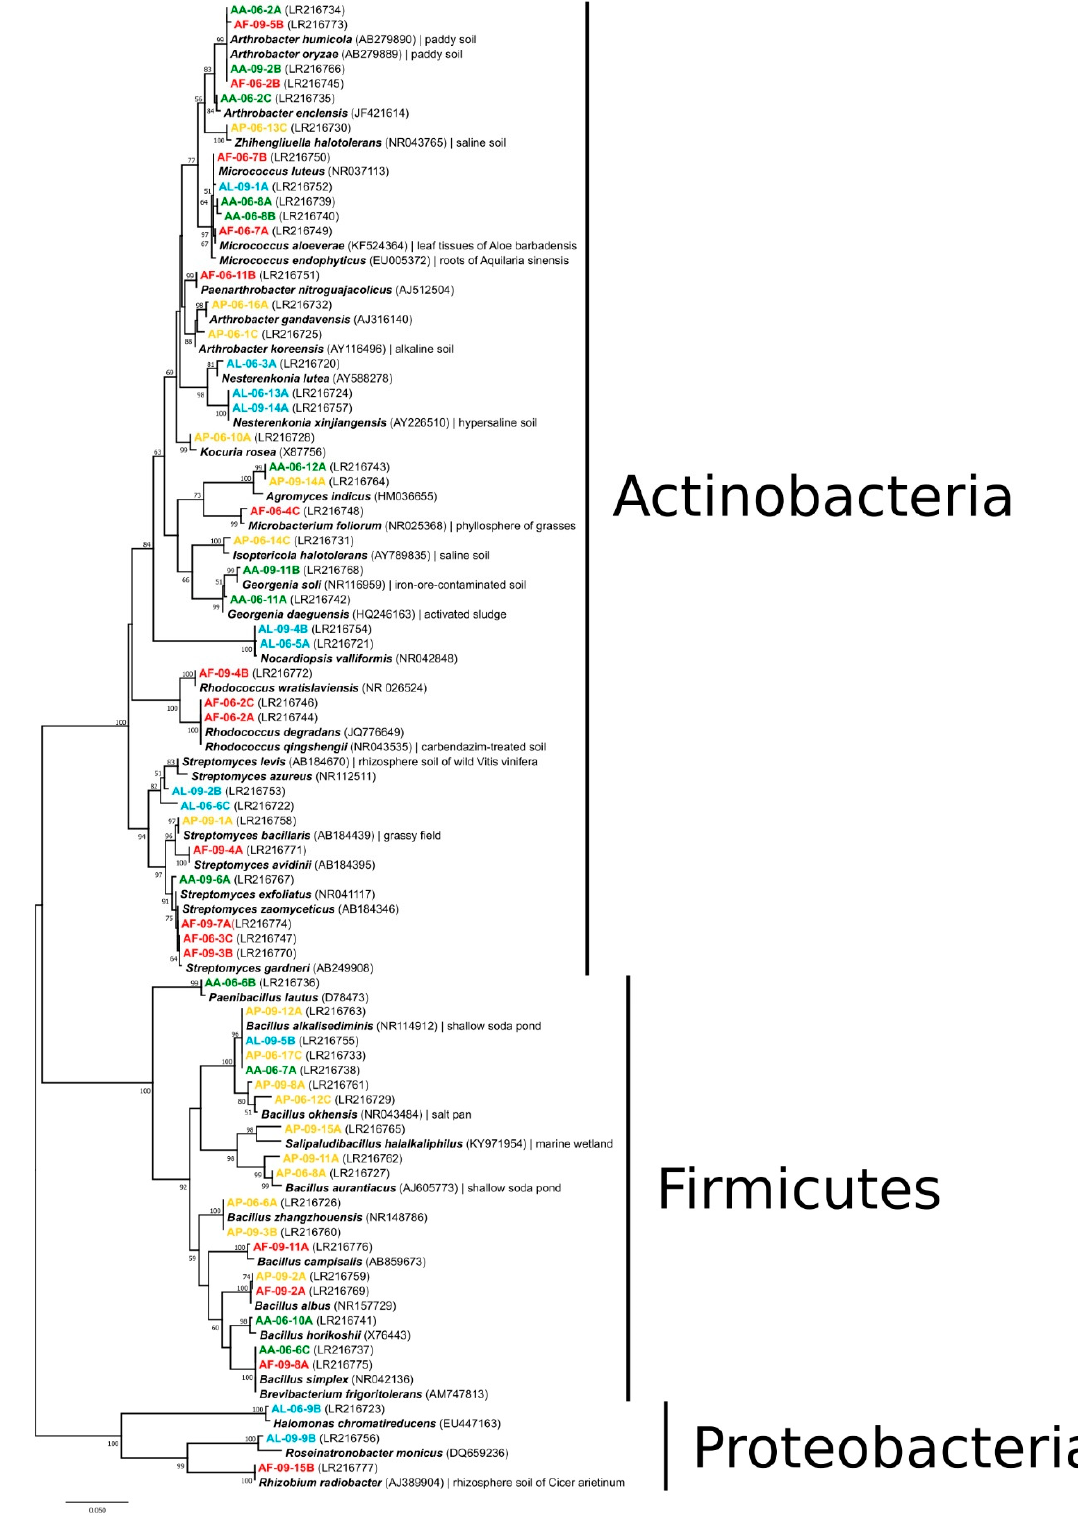
Figure 3. 16S rRNA gene sequence-based phylogenetic relations of bacterial strains isolated from the sodic soil samples originated from different alkali vegetation types. GenBank accession numbers are given in parentheses. Only bootstrap values above 50% are shown (500 replications). Bar, 1 nucleotide substitution per 50 nucleotides. For color codes, see Figure 2.